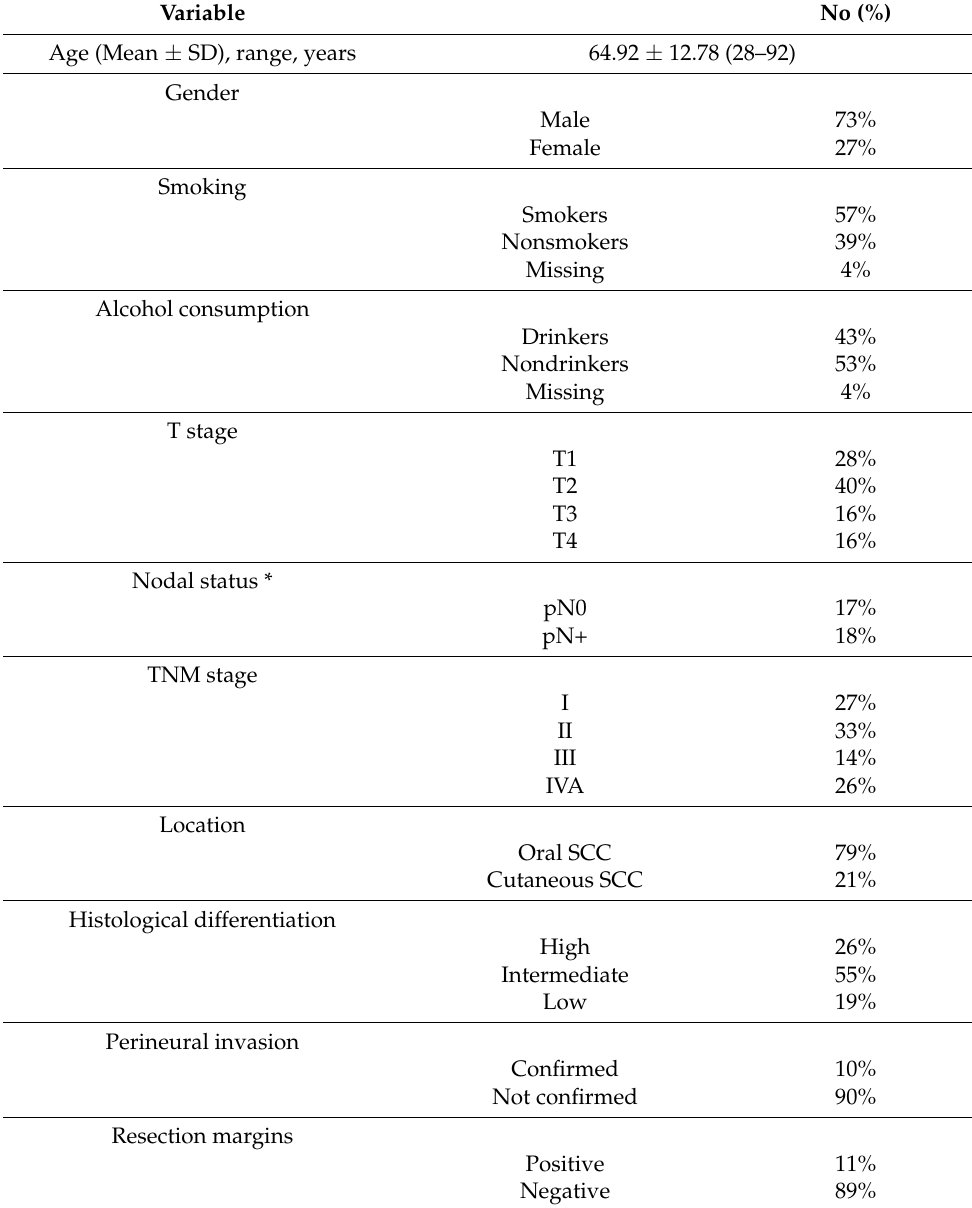
Table 1. Descriptive statistics in Squamous cell carcinoma